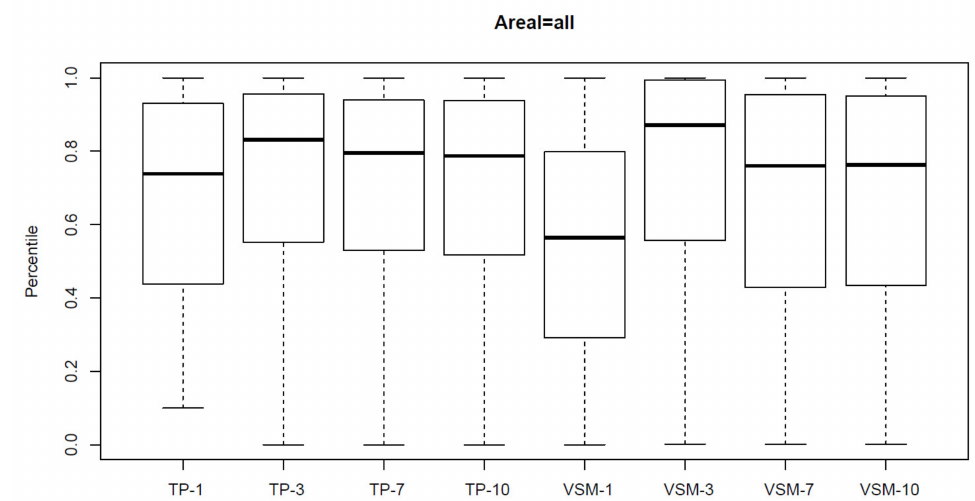
Figure 3. Percentile grid cell values for the daily and antecedent total precipitation (TP) (3, 7 and 10 days; TP-3, TP-7, TP-10, respectively) and daily and antecedent volumetric soil moisture (VSM) (3, 7 and 10-days; VSM-3, VSM-7, VSM-10, respectively). The upper panel shows “single” landslides and the lower panel shows “areal” landslides according to the FraneItalia